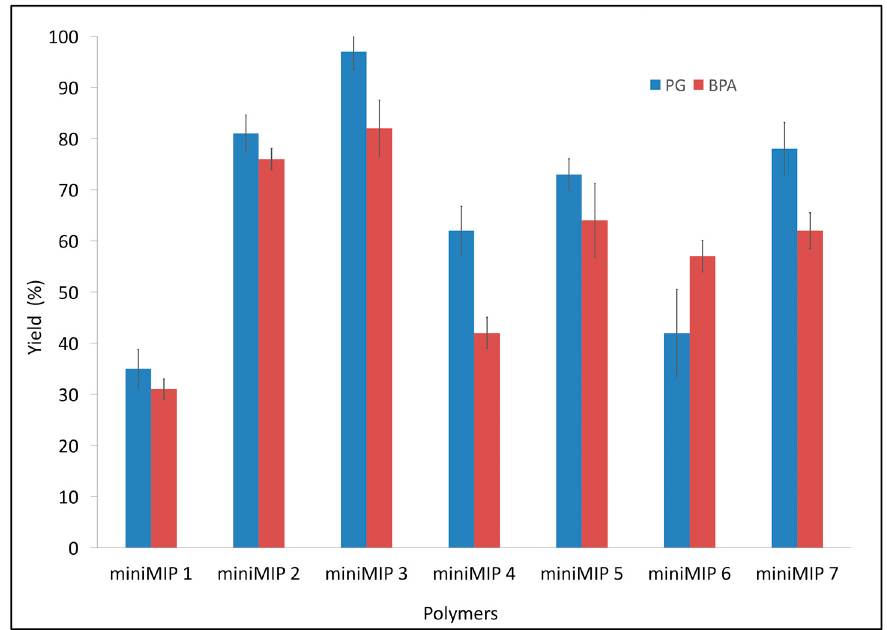
Figure 1. Yield of the synthesis of miniMIPs in different experimental conditions. Error bars represent ±1 standard deviation. All experiments were performed in triplicate.